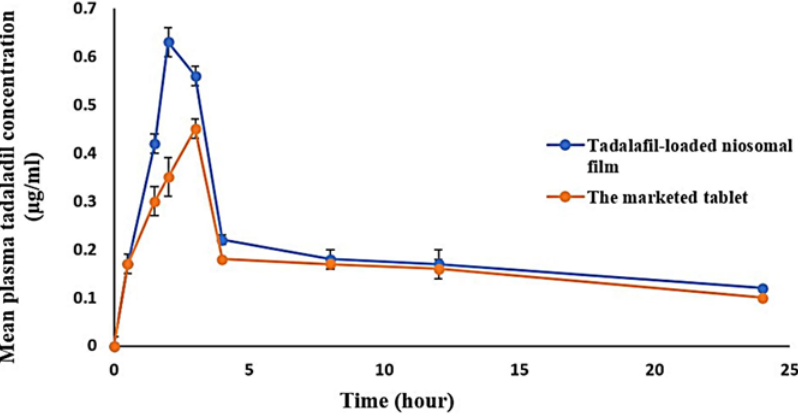
Figure 5. Mean tadalafil plasma concentration versus time after single dose administration of the optimized niosomal oral film and the marketed tablet in two groups of rats. Table 7. Tadalafil pharmacokinetics parameters after niosomal oral film and marketed tablet administration. Pharmacokinetic Parameters